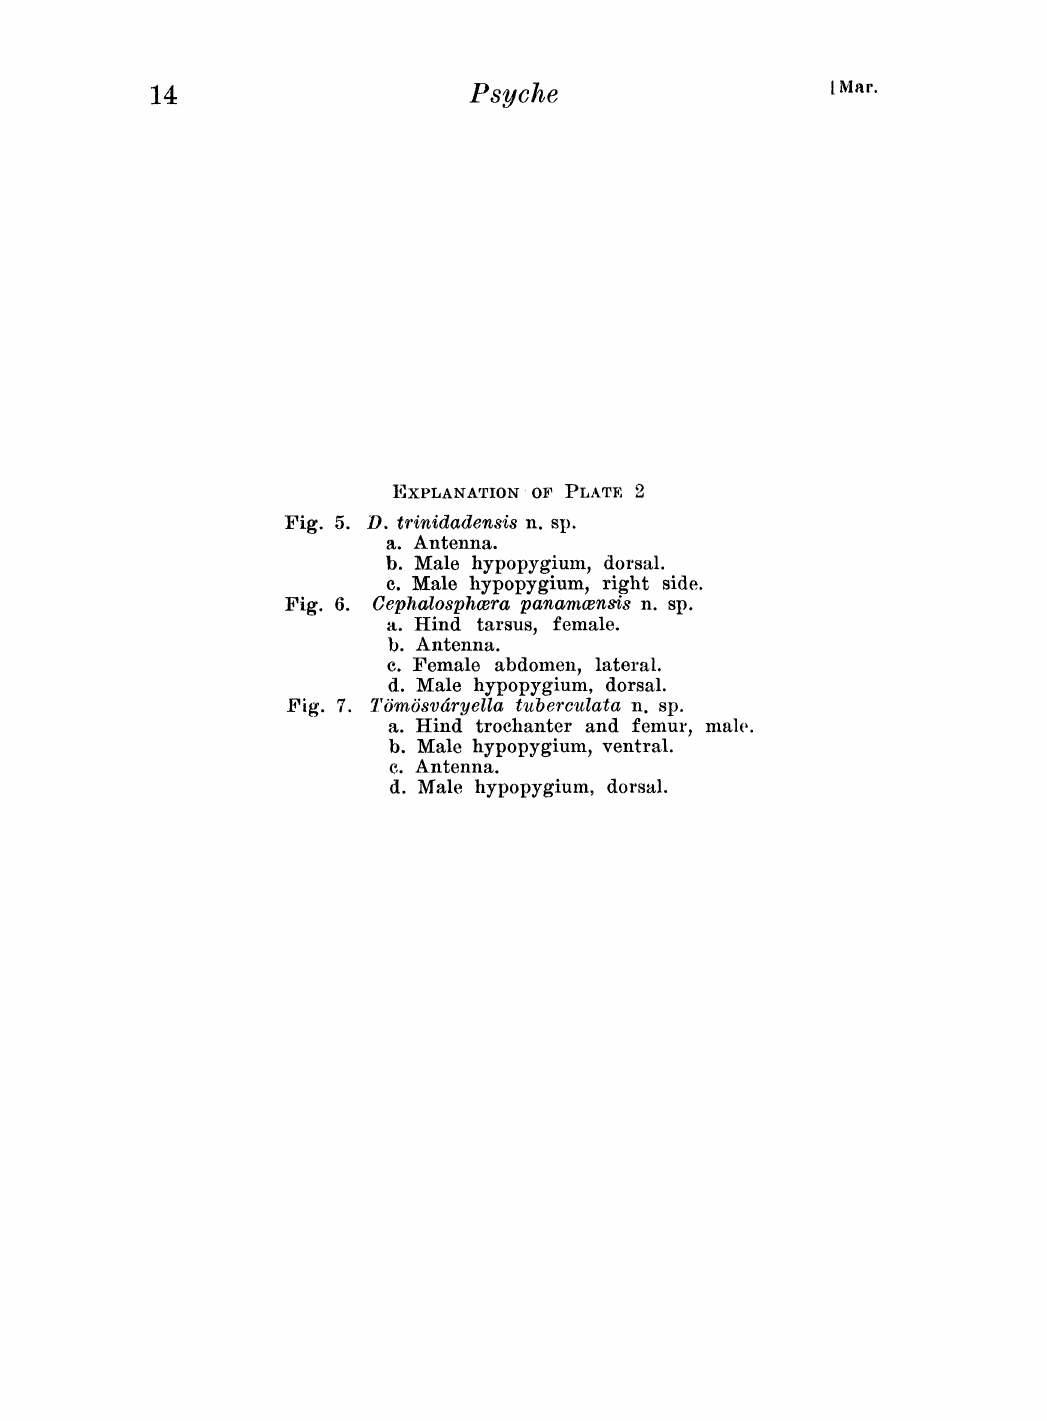
Fig. 5. D. trinidadensis n. sp. a. Antenna. Fig. 6. Cephalosphcera panamvznsis n. sp. a. Hind tarsus, female. b. Antenna. c. Female abdomen, lateral. d. Male hypopygium, dorsal. Fig. 7. TSmSsvdryella tuberculata n. sp. a. Hind trochanter and femur, mah,. b. Male hypopygium, ventral. c. Antenna. d. Male hypopygium,